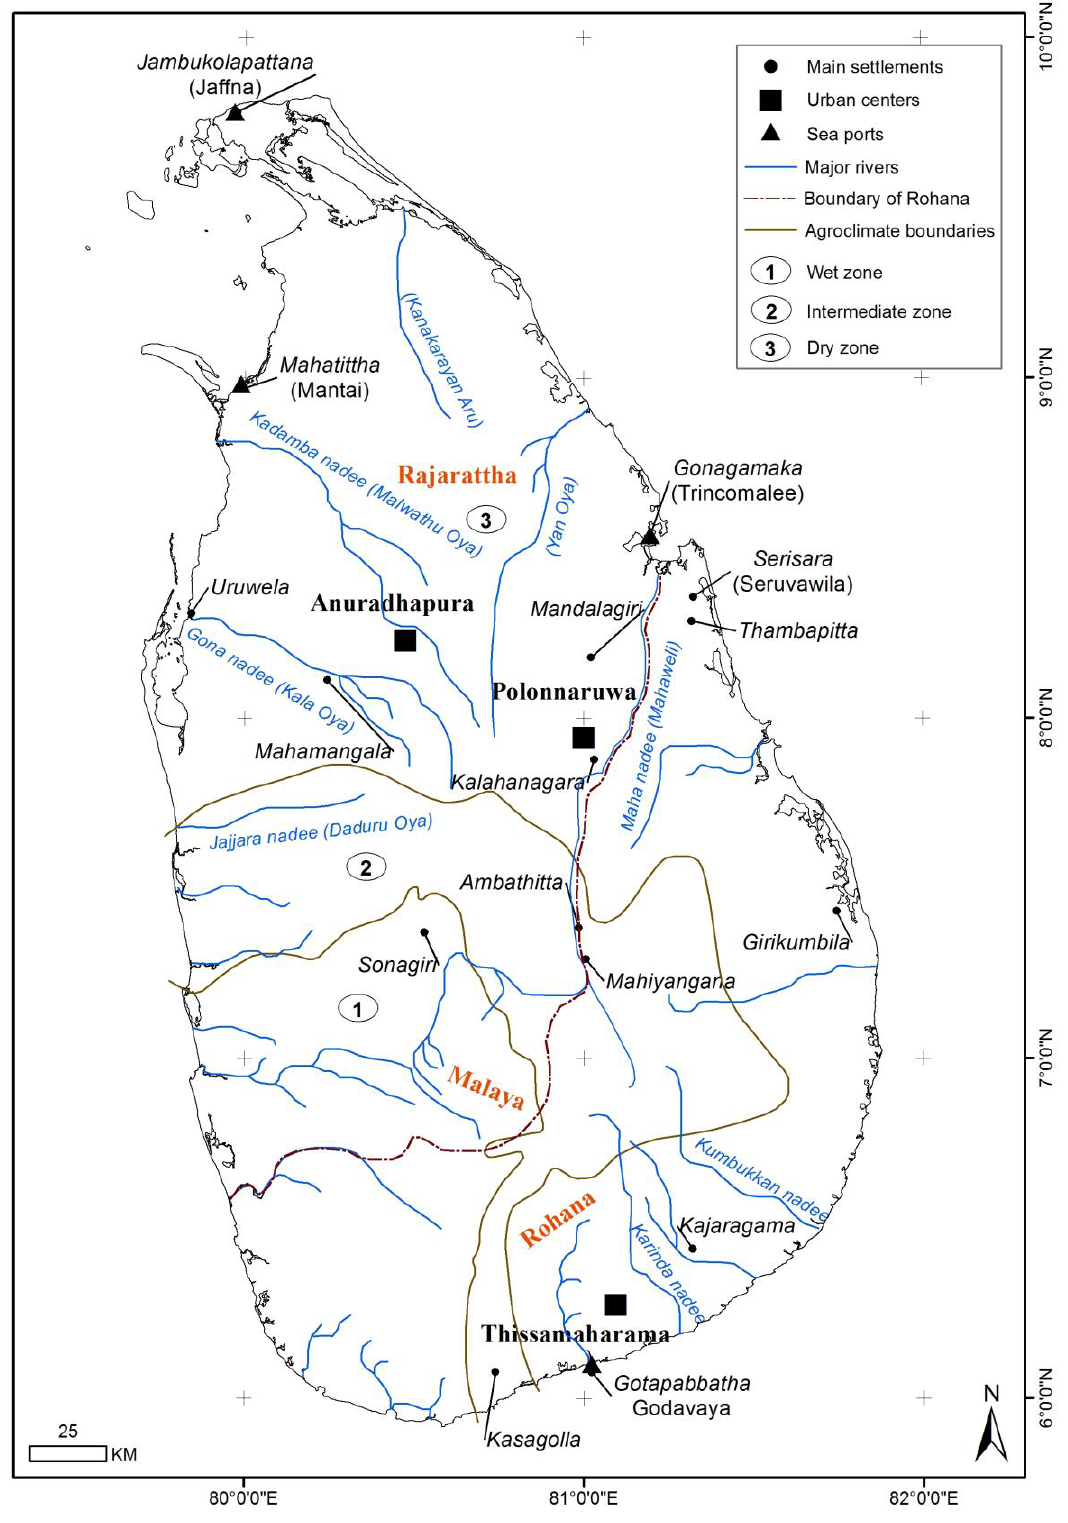
Figure 1. Administrative centers of Sri Lanka during Middle Historic times (c.300—1250 CE) and present-day climatic zones (rivers are based on survey department 1:250,000 topo sheets, climatic zones are based on the National Atlas of Sri Lanka [22], historical place names and administrative units are derived from Liyanagamage and Gunawardhana [23].)